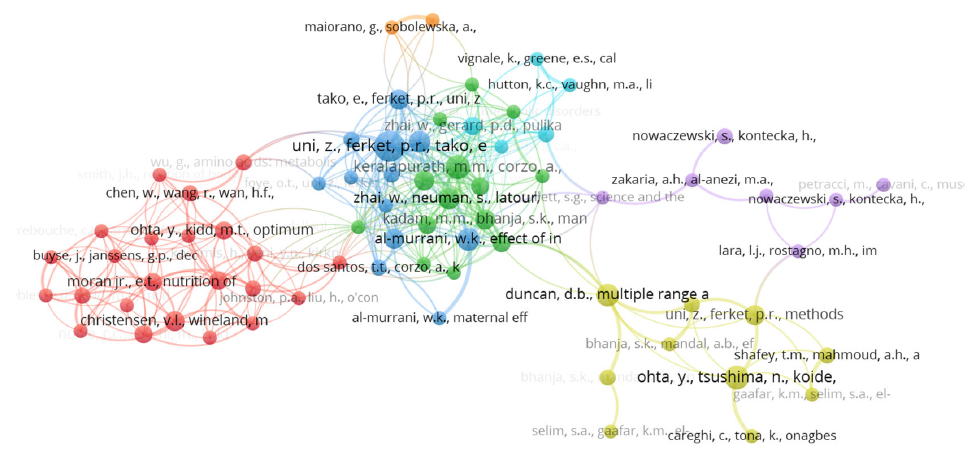
Figure 5. Reference co-citation network.